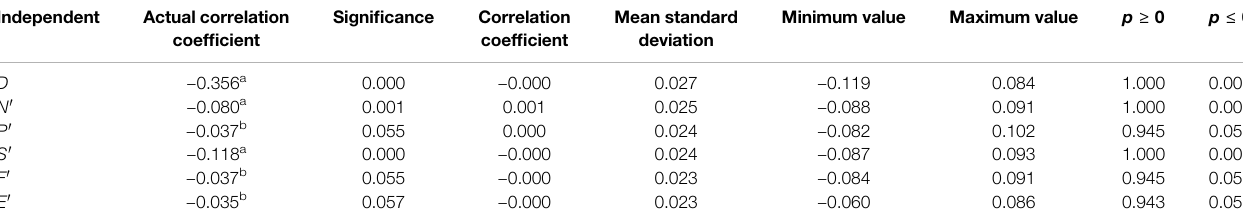
TABLE 5 | QAP analysis results of environmental risk contagion and other driving factors. Independent